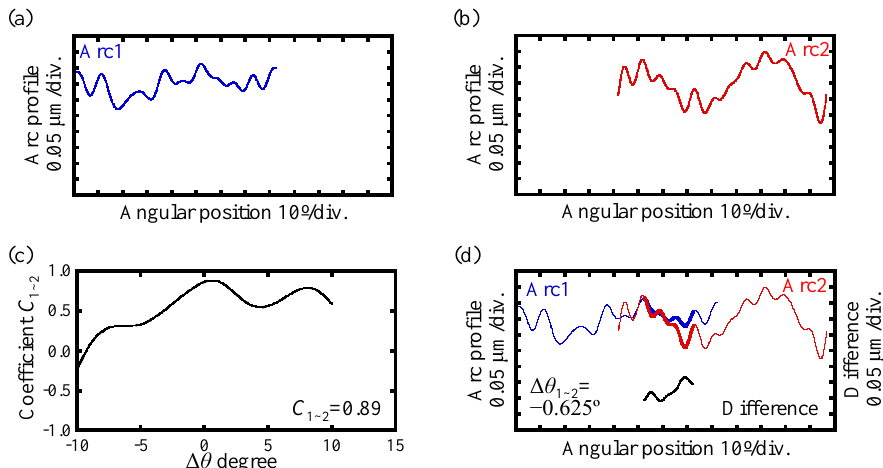
Figure 9. The stitching of the Arc2 with respect to Arc1 by employing the profile data excepting the edge region in Arc2 in the overlapped region: ( a ) Arc1; ( b ) Arc2; ( c ) Variation of the cross-correlation coefficient C 1~2 due to the change in Δ θ ; ( d ) The stitched Arc1 and Arc2 at Δ θ = Δ θ 1~2 .